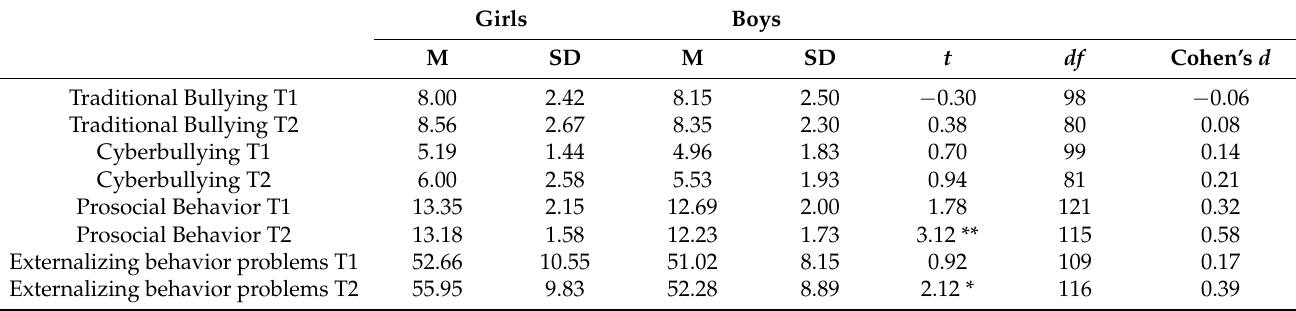
Table 3. t -test for independent samples for gender differences.